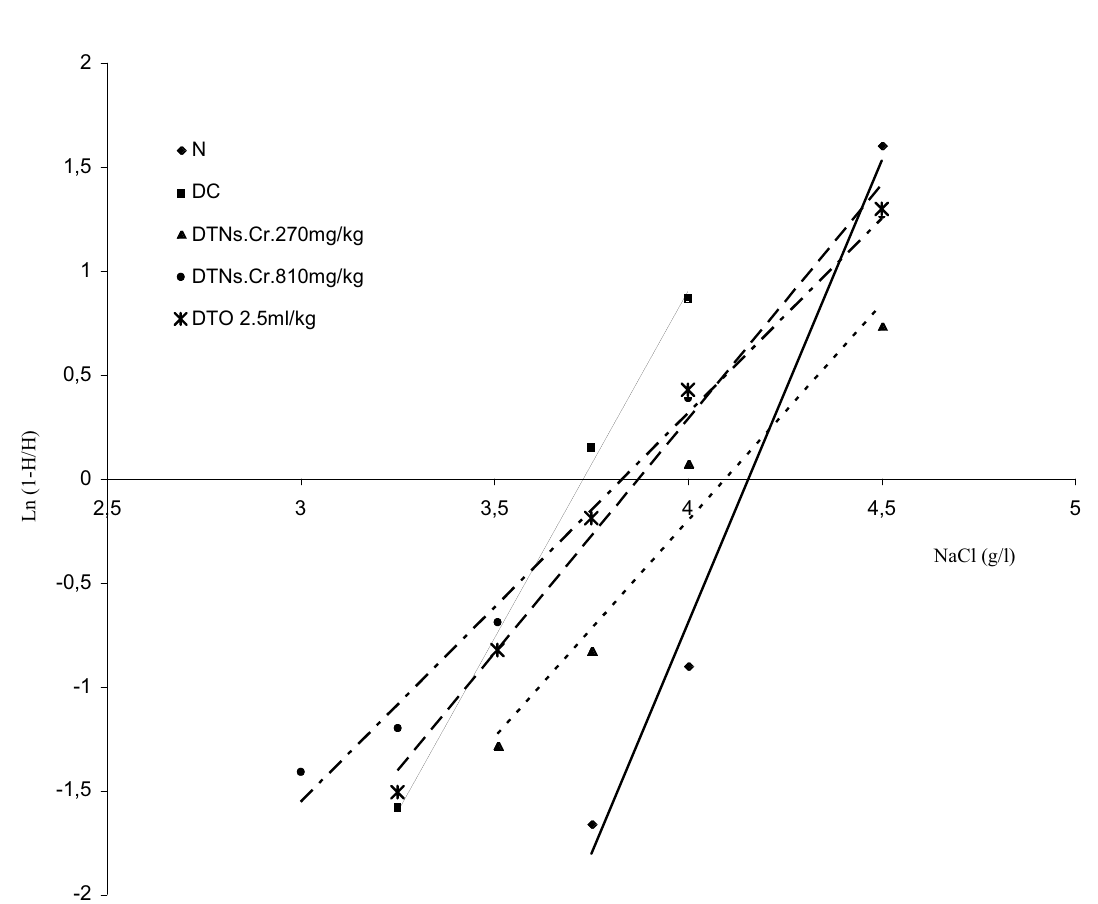
Figure 5. Linear representation of heamolysis curves from Fig. 4. N, normal rats group (n=5); DC, diabetic con- trol rats group (n=5); DTNs.Cr, N. sativa crude extract treated diabetic rats group (n=5); DTO, oil treated diabetic group (n=5). Values are expressed as mean ±